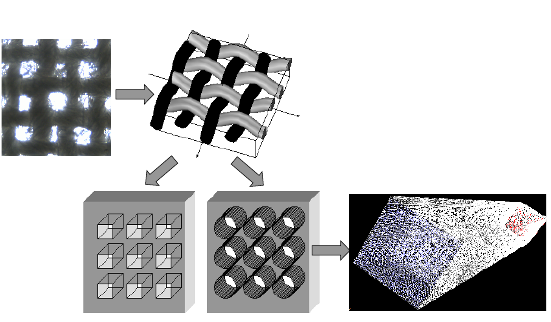
Figure 2. Approximation of the woven structure to jet systems, ready for CFD simulation